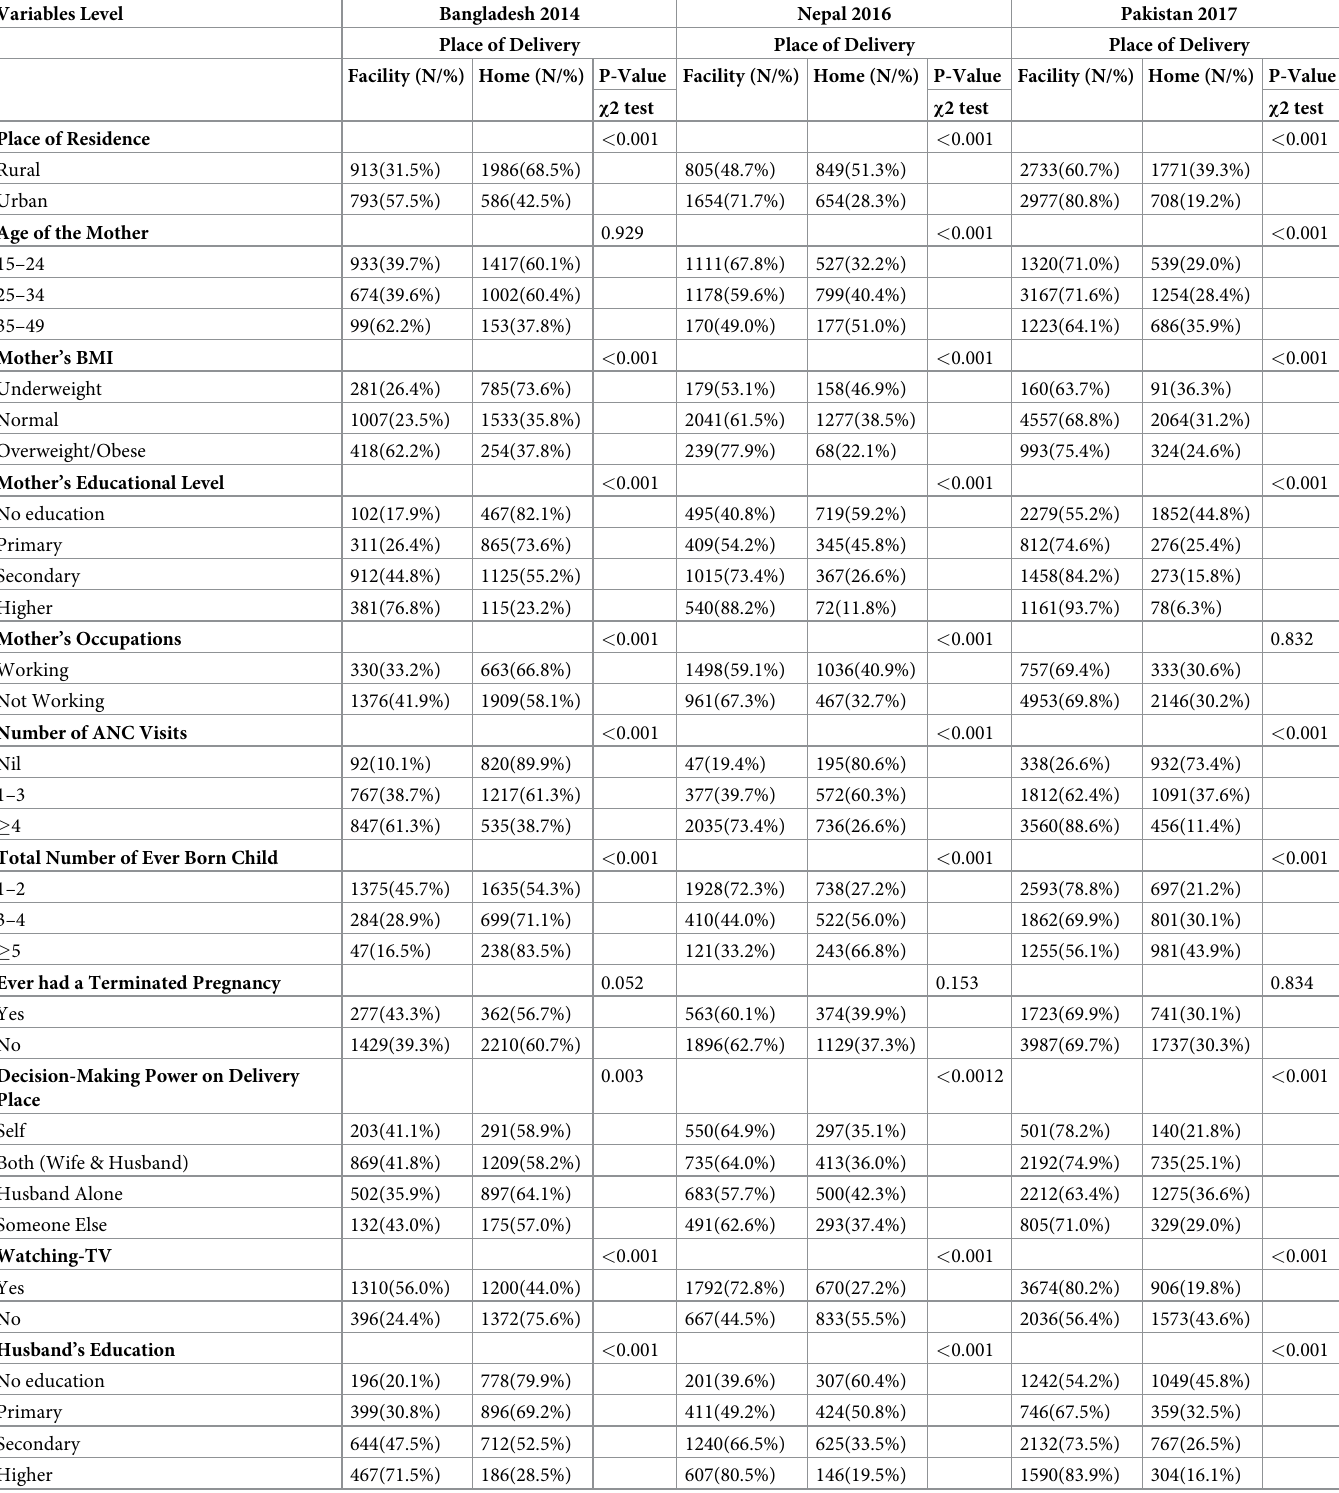
Table 2. Percent distribution and preferred place of delivery by background characteristics: BDHS 2014, NDHS 2016, PDHS